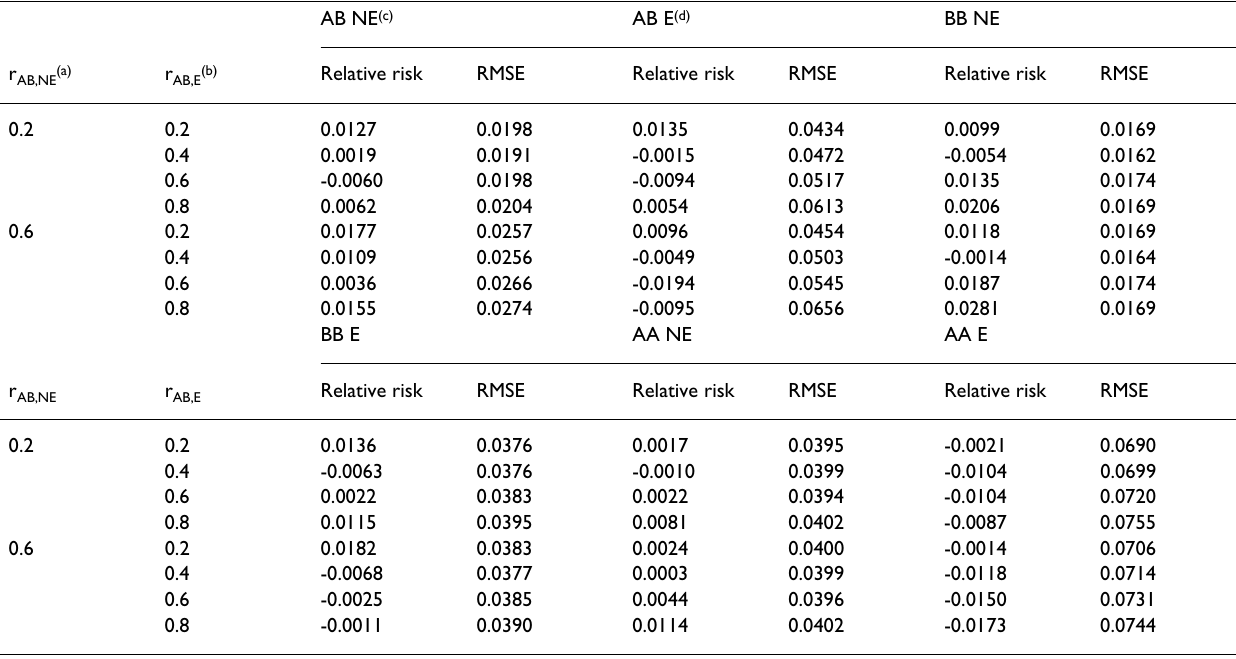
Table 4: Relative bias and RMSE of the estimated disease risks predicted using the full model in the second